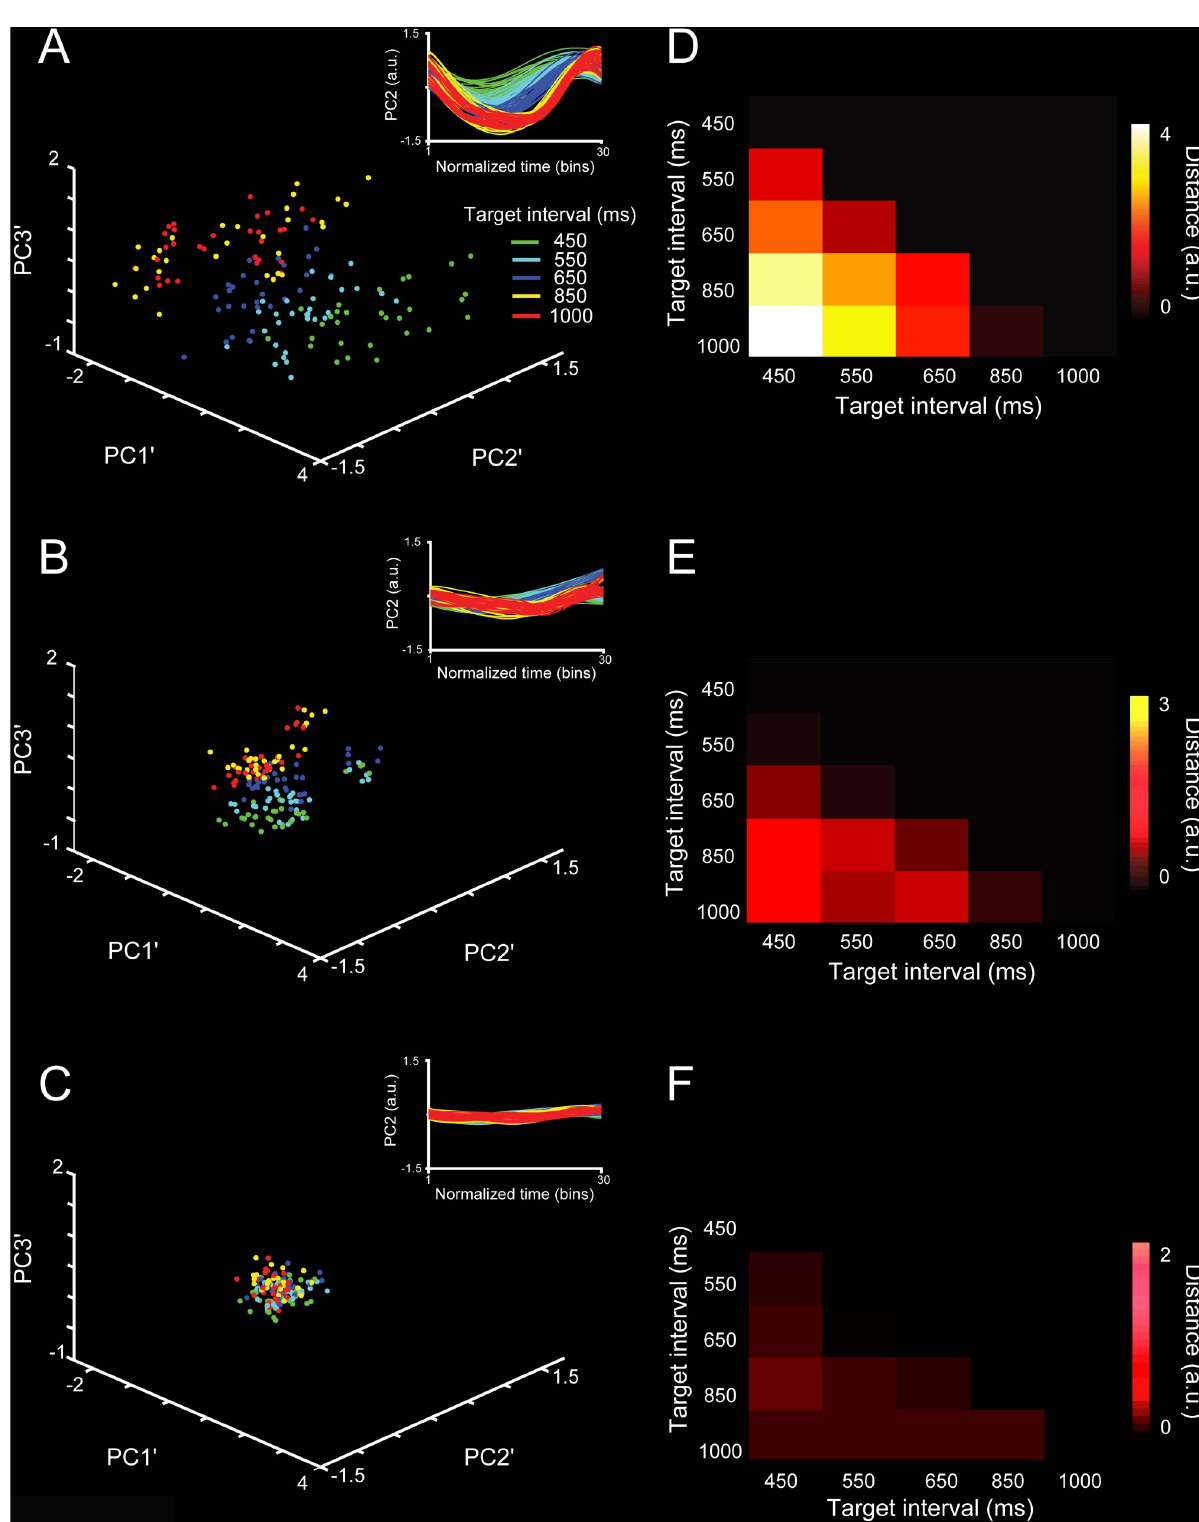
Fig 6. Robustness in the classifier for SCT target interval using segments of the PCA neural trajectory between taps with different neural population sizes. A-C. Three principal components projection of the second-layer PCA 0 applied to each of the six inter-tap neural trajectory segments and the five trial repetitions (see inset) for ( A ) 100%, ( B ) 50%, and ( C ) 1% of the neural population. Each dot in the second-layer PCA 0 corresponds to